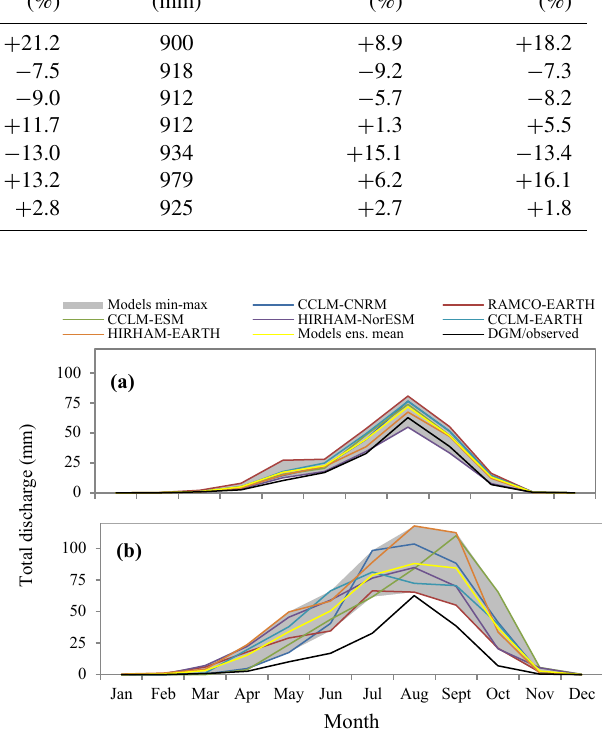
Figure 7. Historical RCM–GCM based discharge simulations and observation based discharge: (a) RCM rainfall is bias corrected, (b) RCM rainfall non bias